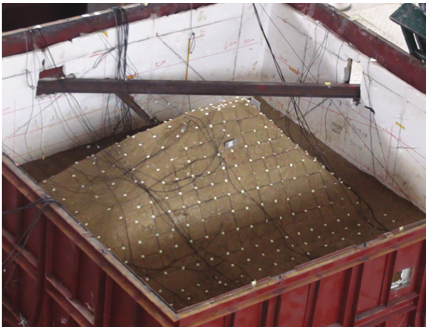
Figure 3: Shaking table test of rock slope.